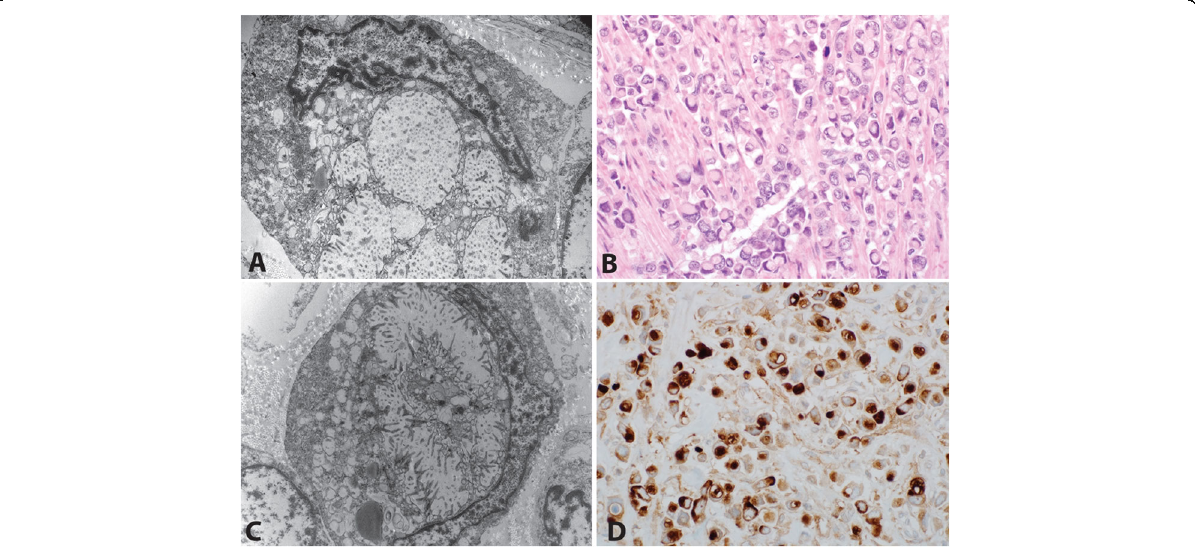
Fig. 5 Electron microscopy analysis and CD10 immunostain of plasmacytoid urothelial carcinoma. Electron microscopy was performed on a representative section of tumor demonstrated nuclei pushed aside by intracellular vacuoles with microvilli lining the inner surface ( a , c ), Hematoxylin and eosin of the tumor ( b ) and a CD10 immunostain showing an apical cytoplasmic staining pattern, similar to those reported in microvillous inclusion disease ( d